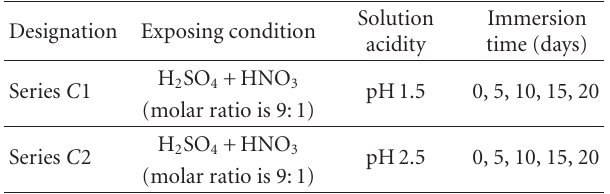
Figure 1: Concrete specimens conditioned in the mixed acid solution. Table 2: Condition details.